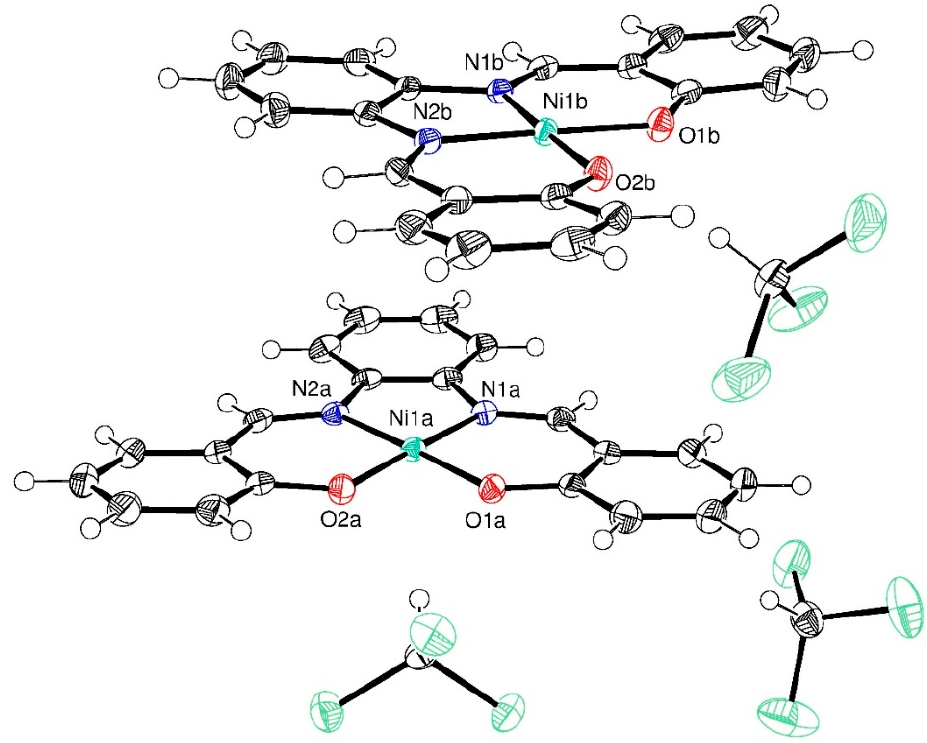
Figure 7. Perspective of the compound Ni salphen with a displacement ellipsoids at a 55% probability level for non-H atoms.